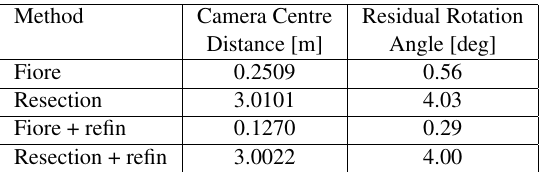
Table 1: Camera orientation average